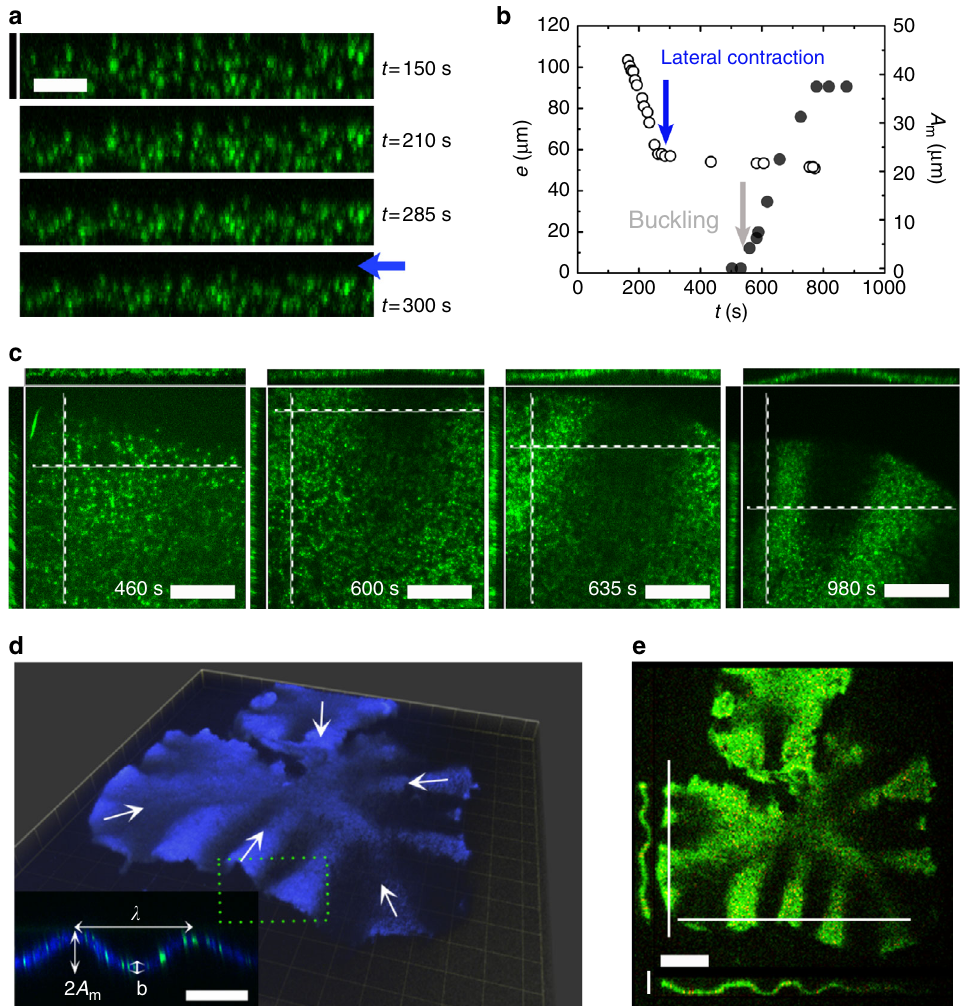
Fig. 2 Buckling of an acto-myosin sheet. a Spinning disk confocal fl uorescence micrographs of actin in the xz plane of a contracting gel. The blue arrow marks the time when lateral contraction sets in and indicates the direction of contraction. Vertical scale bar: 100 μ m, horizontal scale bar: 50 μ m. b Evolution of gel height e and buckling amplitude A m for the gel in a . The blue arrow marks the time when lateral contraction sets in and the gray arrow marks the time when the sheet starts to buckle at the periphery. c Spinning disk confocal fl uorescence micrographs of the actin gel in a in the xy plane (top view), the xz plane (top side view), and yz plane (left side view). Side views ( xz and yz planes) are measured along the white dotted lines. Scale bar: 180 μ m. d Laser scanning confocal micrograph of a three-dimensional view of a buckling gel at steady state. Inset: side view of the gel indicating the wavelength λ , fi nal gel thickness b , and buckling amplitude A μ m. e Top view ( xy plane) and side views ( xz and yz planes) along the white lines of the gel m . Scale bar: 100 in d . Horizontal scale bar: 200 μ m. Vertical scale bar: 80 μ m. Drop volume is 4.9 μ L ( a – c ) and 4.6 μ L ( d , e ). Chamber height h = 160 μ m ( a – c ), h = 80 μ m ( d , e ). Initial gel radius R = 3.1 mm ( a – c ), R = 4.3 mm ( d , e ). Actin was labeled with Alexa-Fluor 488 (green in a , c , e , blue in d ), myosin was labeled with Alexa-Fluor 568 (green in d , red in e ). d , e Same gel as in ref. 5 Fig.